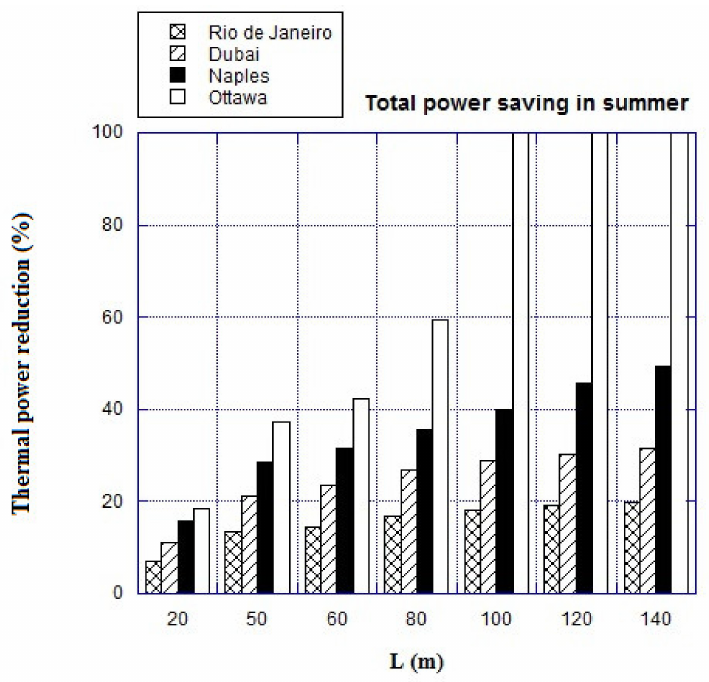
Figure 12. Percentage reduction of thermal power of the coils in the AHU during summer operation mode for the four cities by varying the length of the buried pipes of the GAHX and fixing the air flow velocity to 2.5 m s − 1